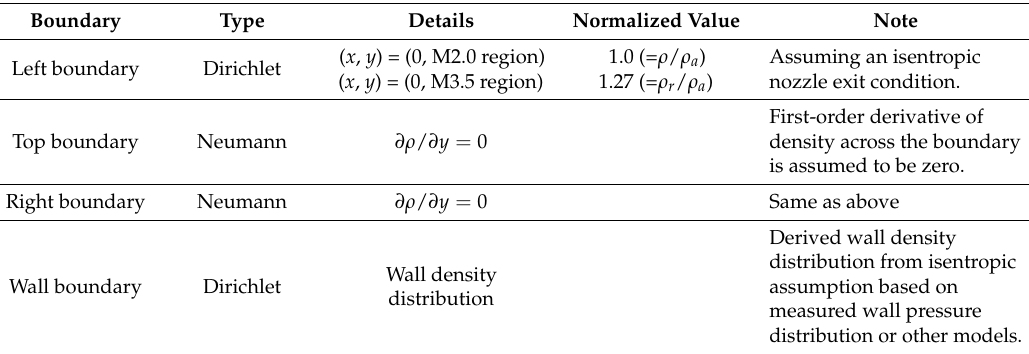
Table 3. Boundary conditions for Poisson’s equation.